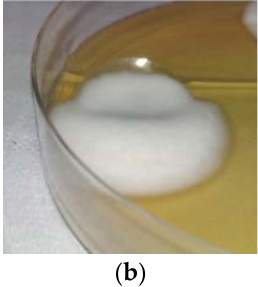
Figure 7. Scanning electron microscopy (SEM) micrographs of KF-110 films ( a , c ) and nail plates ( b , d ) at magnifications of 1000× ( a , b ) and 25,000× ( c , d ). White circles on ( c ) and ( d ) point on pores size of which was measured.